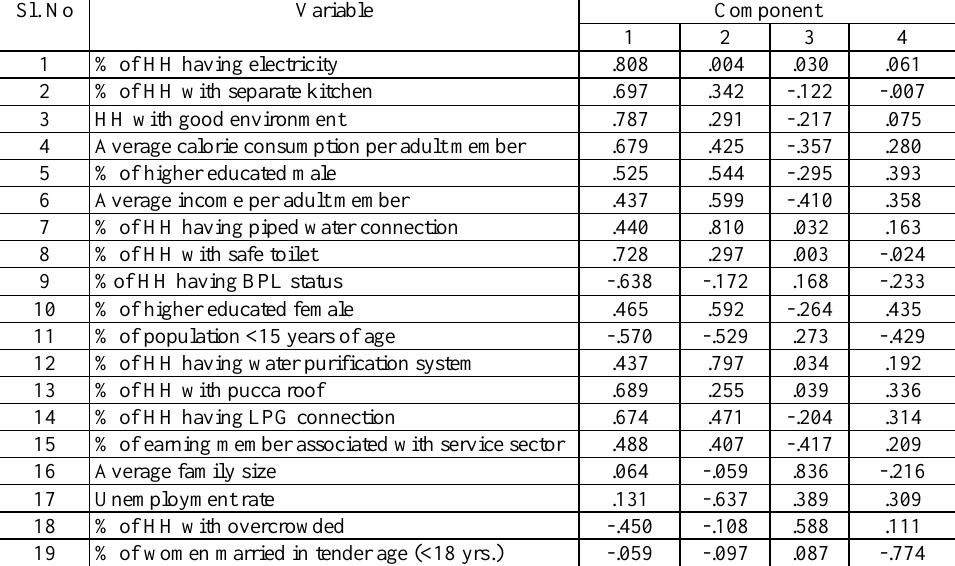
Table 2. Variables considered for Principal Component Analysis